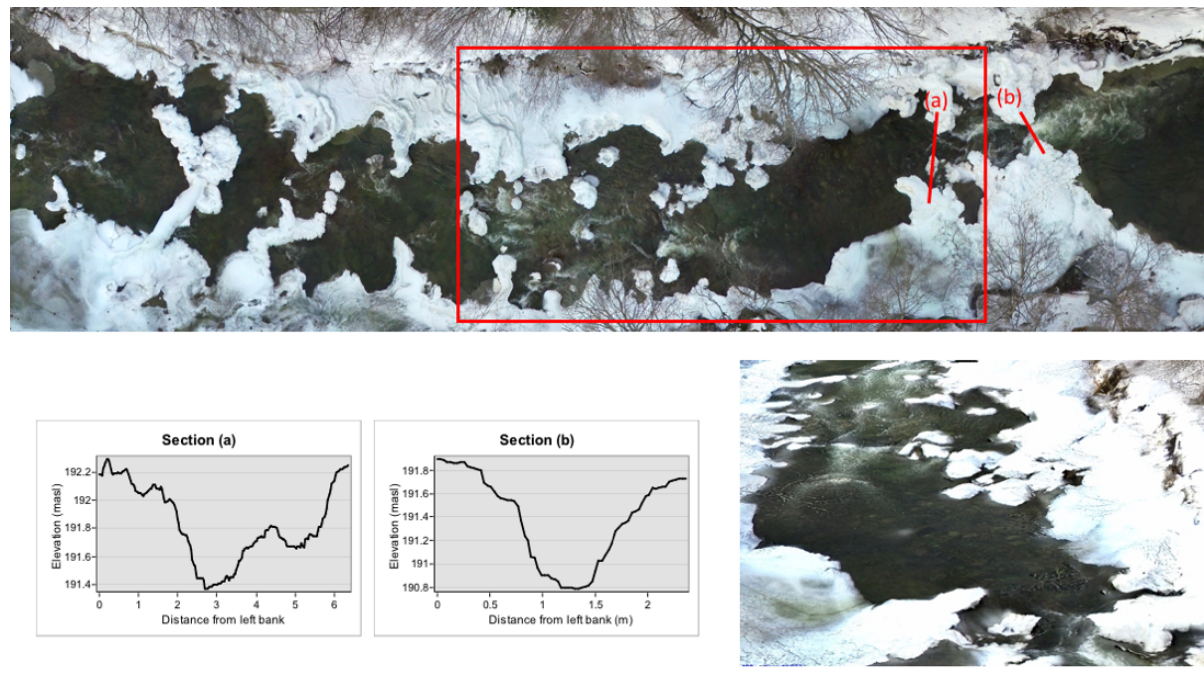
Figure 3. Partly broken anchor ice dams in the Sokna reach. The upper picture shows an orthophoto mosaic of the reach, the lower graphs shows the two sections (a) and (b) marked on the picture and the picture shows the area in the red rectangle as seen from